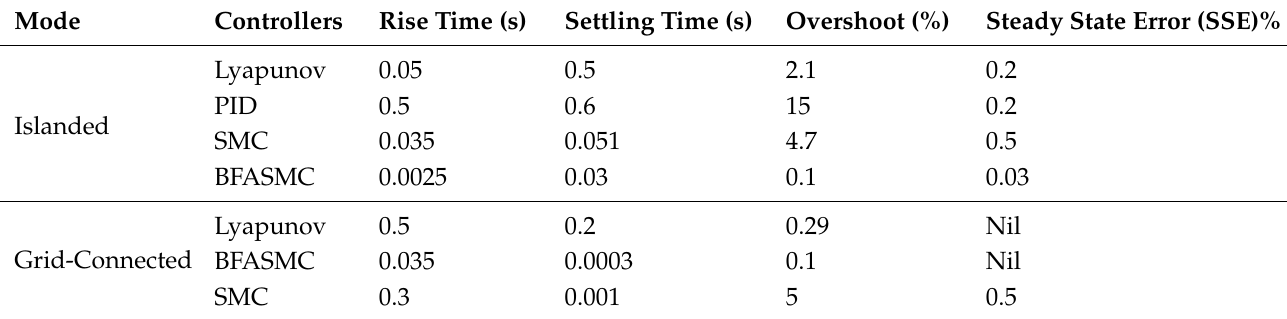
Table 5. Comparison